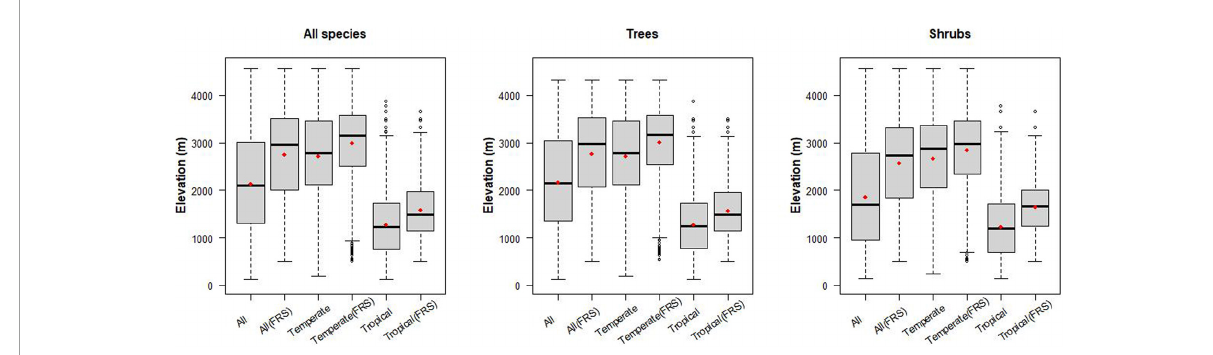
FIGURE3 Elevation differences for tropical- and temperate-originating trees and shrubs along the elevation gradients of Bhutan. We also assessed the elevation distributions for species that are located higher than 500 m so their entire elevation range was represented in the sampling. FRS in the x-label represents “Full Range Sampled.” Red point in each bar is the mean elevation within group.